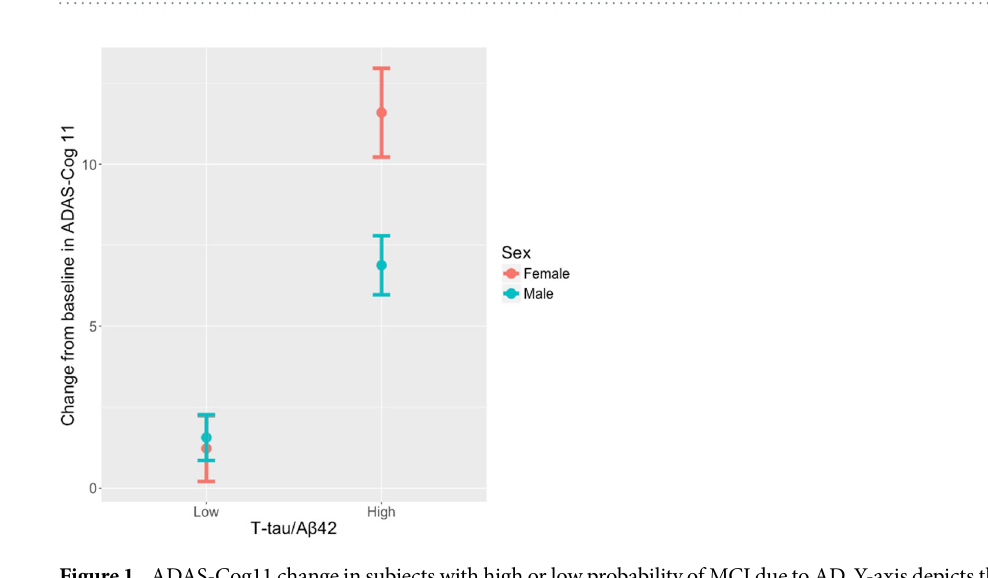
Figure 1. ADAS-Cog11 change in subjects with high or low probability of MCI due to AD. Y-axis depicts the mean (SE) change from baseline in ADAS-Cog11 of MCI subjects by sex. X-axis depicts the grouping by CSF t-tau/ A β 42 ratio into “high” or “low” likelihood of having MCI due to AD. MCI due to AD high probability subjects had greater change than those with low probability. Among subjects with high probability of MCI due to AD, females showed greater change than males. Data comprises pooled MCI subjects from ADNI-1 and ADNI-2.